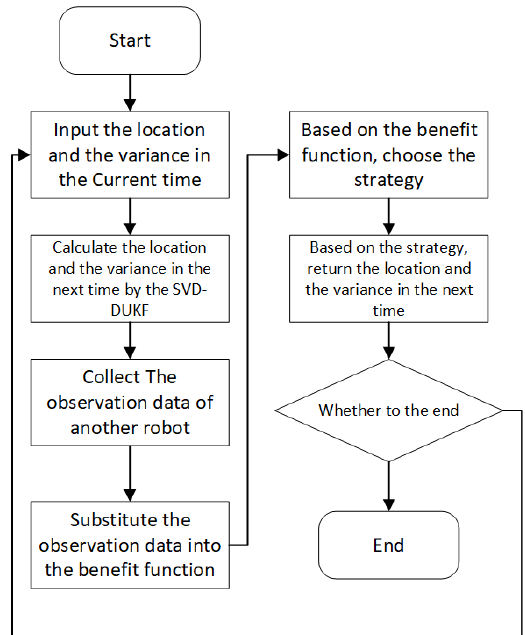
Figure 5. The flow chart of the static game theory algorithm based on SVD-DUKF.